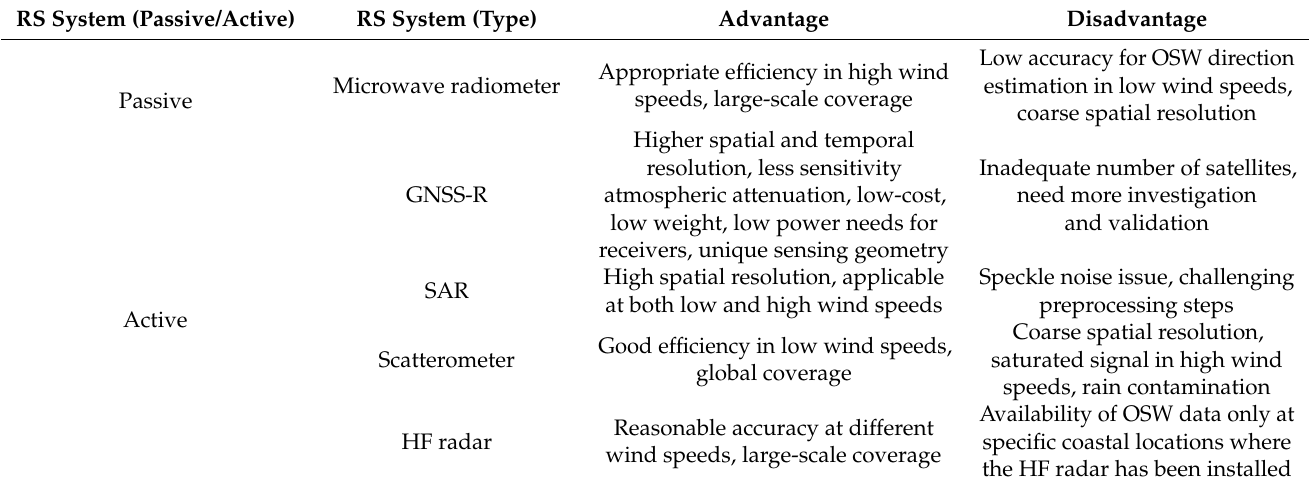
Table 1. Different RS systems for OSW estimation along with their advantages and